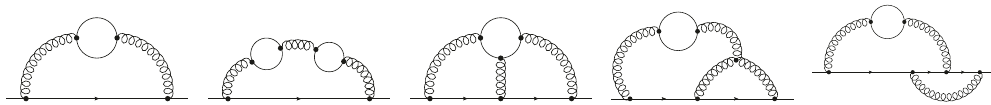
Figure 1. Sample Feynman diagrams contributing to Z OS represent quarks and gluons, respectively. The fermions in the closed loop may have a di(cid:11)erent mass from the external